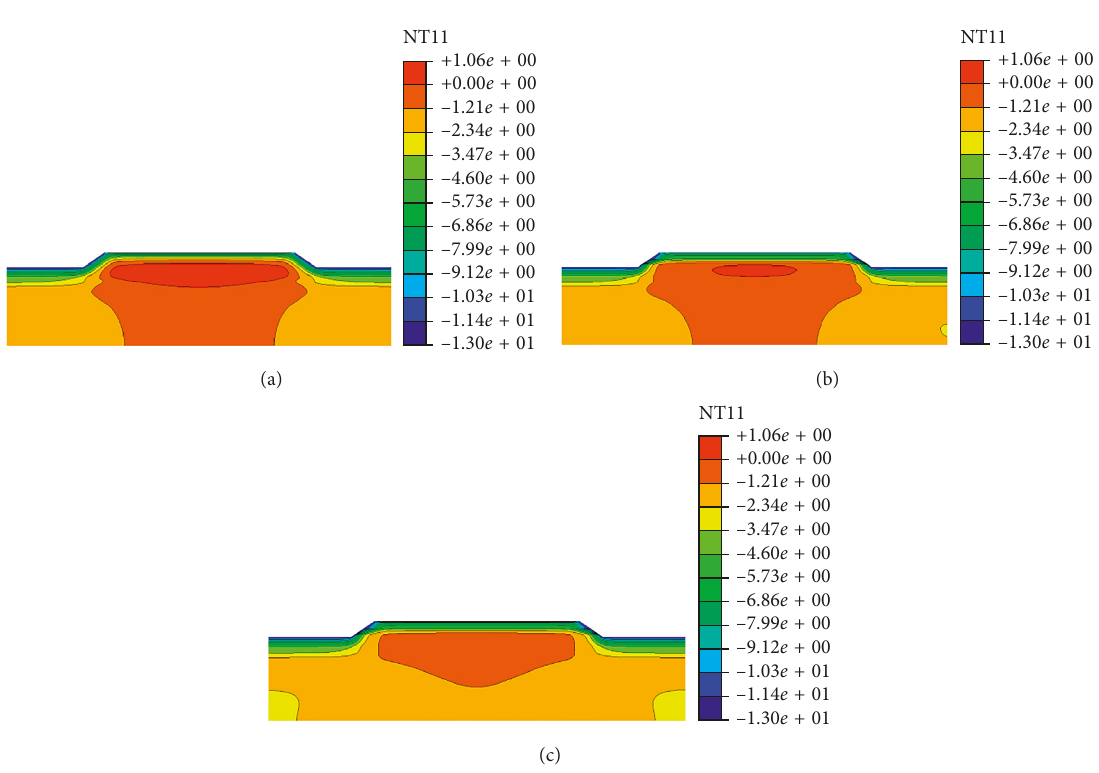
Figure 8: The tenth-year temperature fields in January for different embankments: (a) normal embankment, (b) CS embankment, and (c) RRVCS